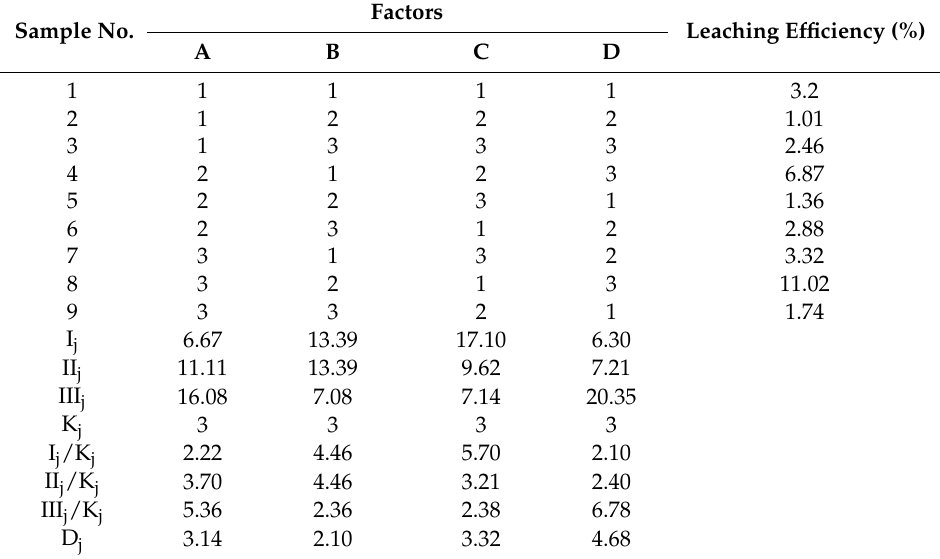
Table 6. L 9 (3 4 ) Orthogonal experiment design and acid leaching efficiencies of Nb (%).